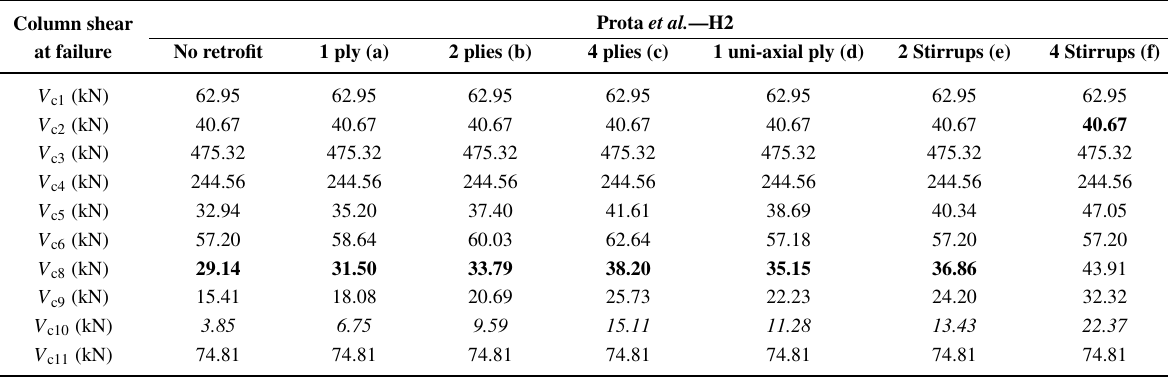
Table 10. Theoretical prediction of capacities for each potential failure modes of different retrofit solutions for specimens “H2” (Prota et al.